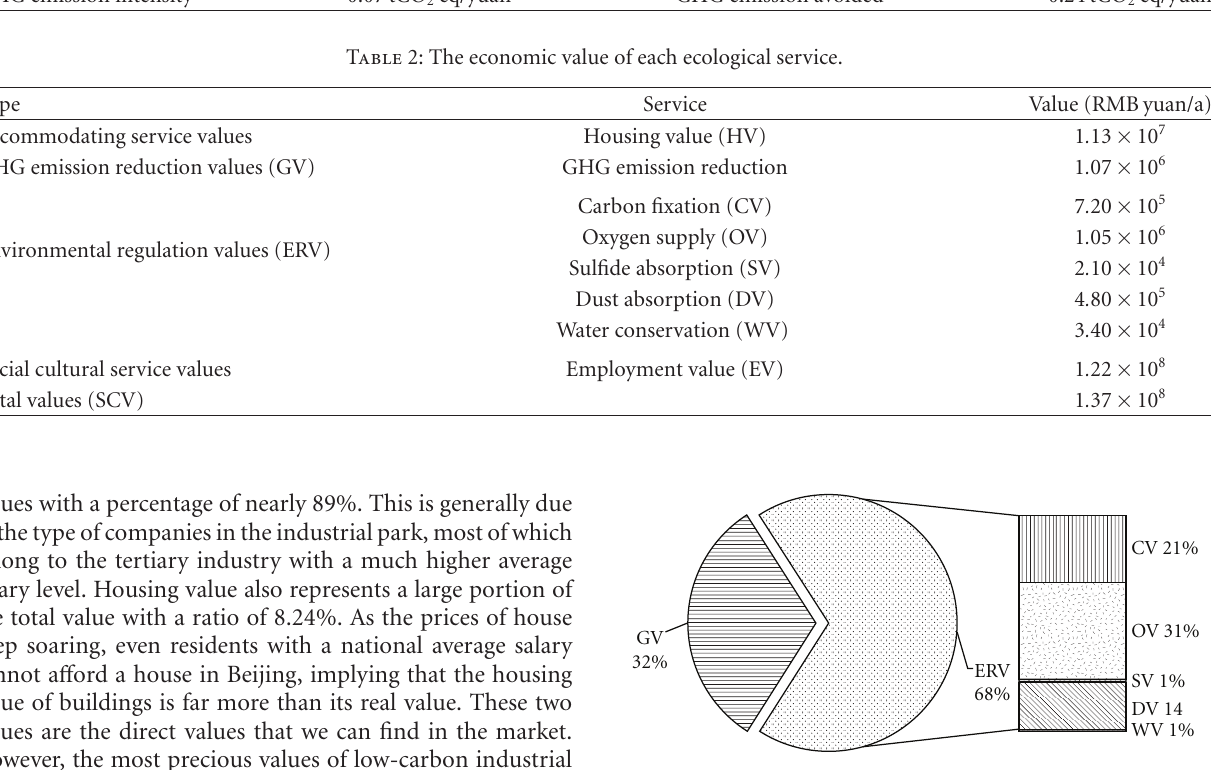
Figure 2: The proportion of CV and ERV of the low-carbon indus- trial